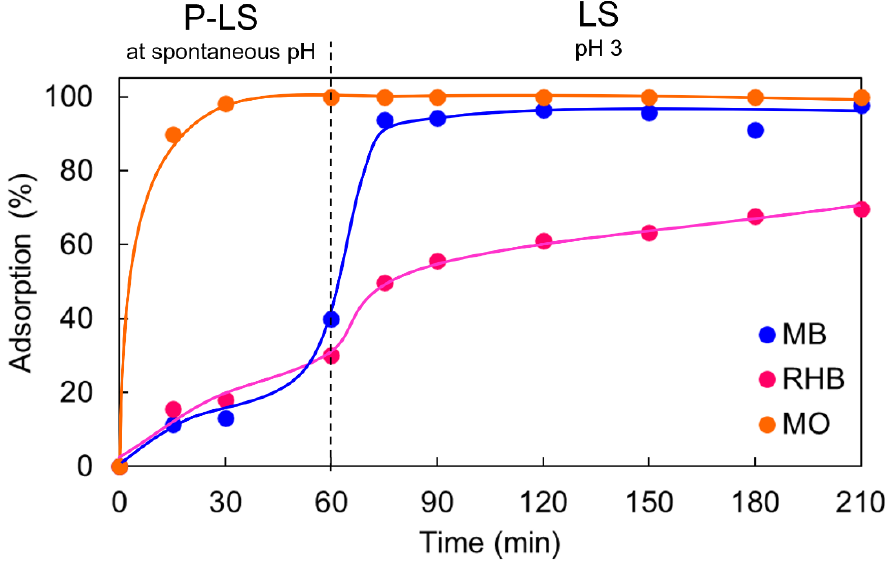
Figure 12. Selective adsorption of MO, MB, and RHB in mixture by a two-step pH-driven approach using P-LS and LS.